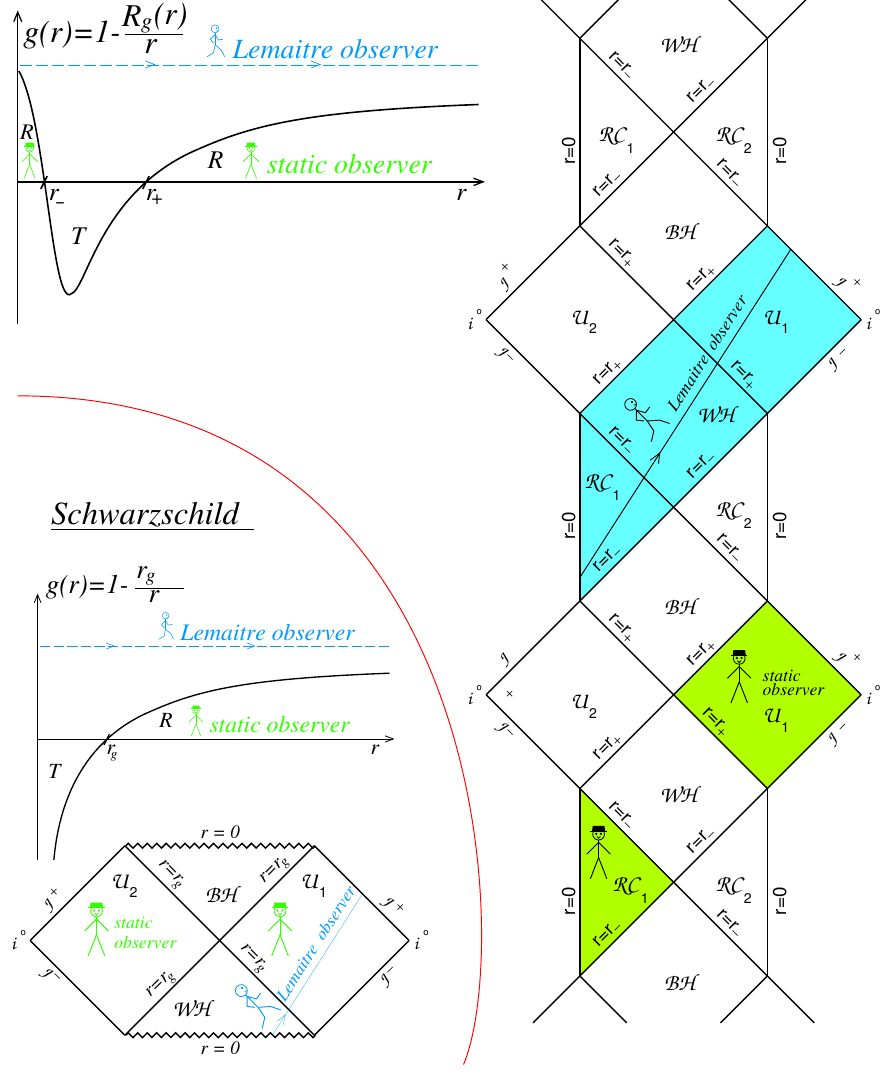
Figure 2. Penrose–Carter diagram of spacetime for a regular black